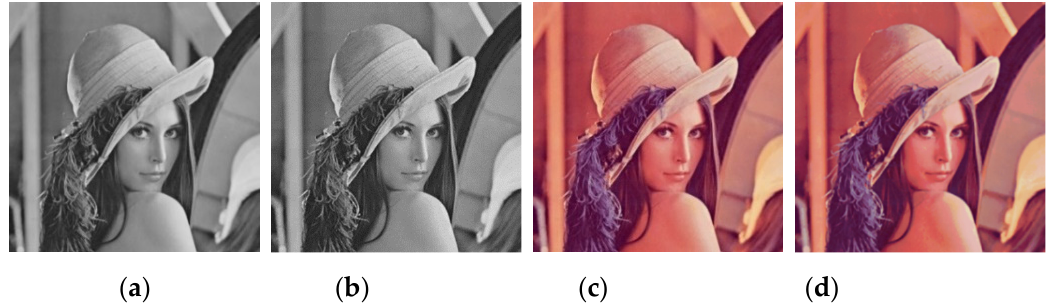
Figure 5. Lena images with different pixel depths: ( a ) 8 BPP (grayscale); ( b ) 16 BPP (grayscale); ( c ) 24 BPP (color); ( d ) 32 BPP (color).